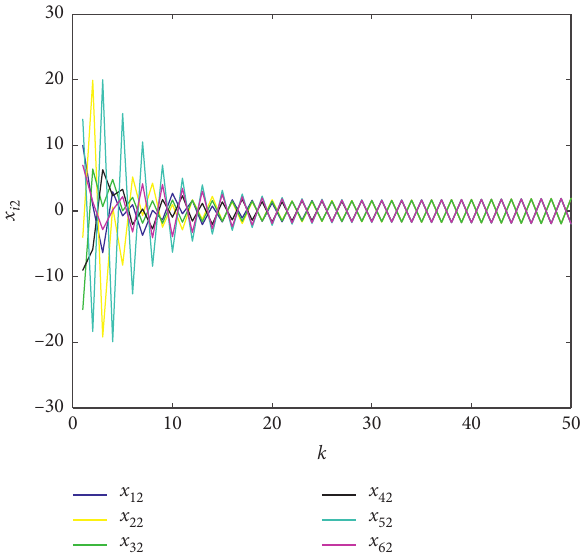
Figure 5: The trajectories of x feedback